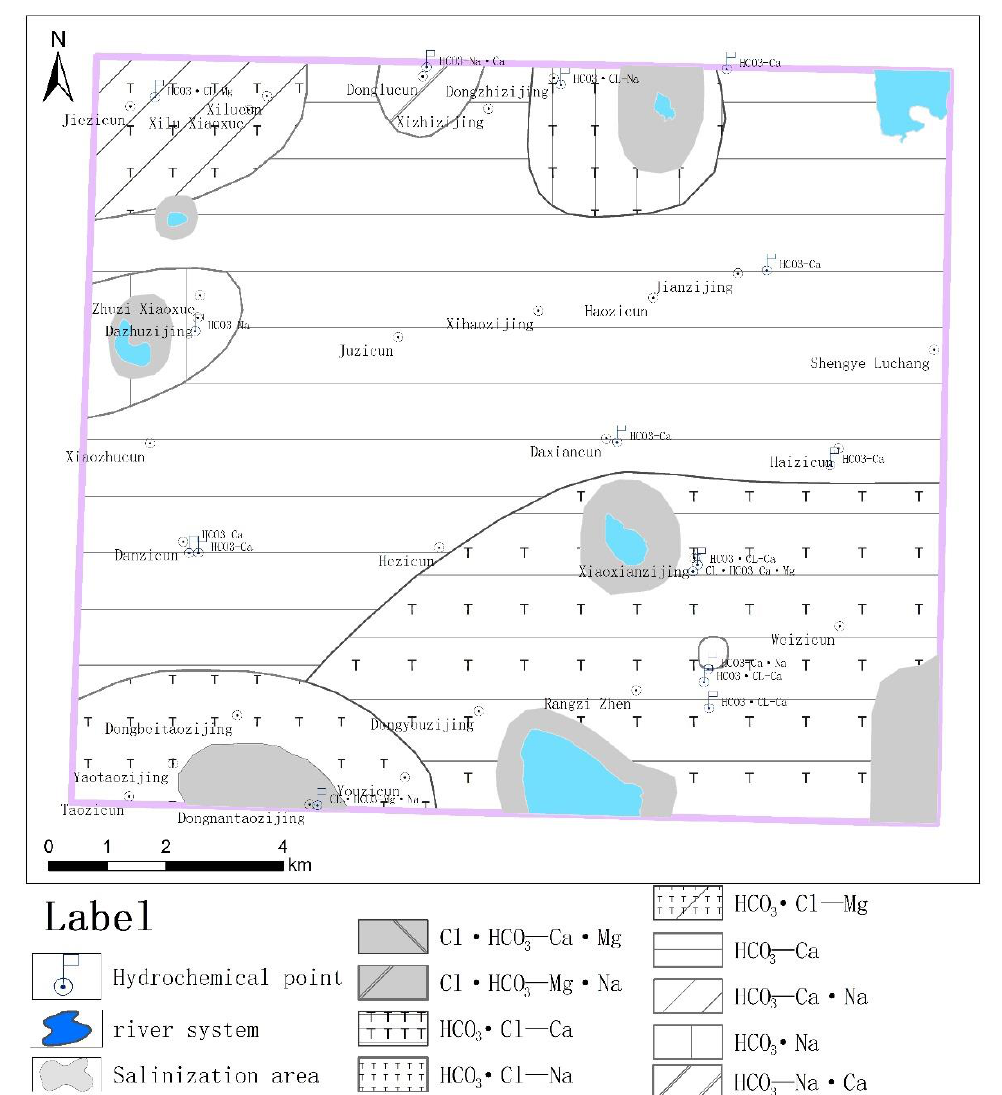
Figure 4. Division of groundwater hydrochemical types in the study area.